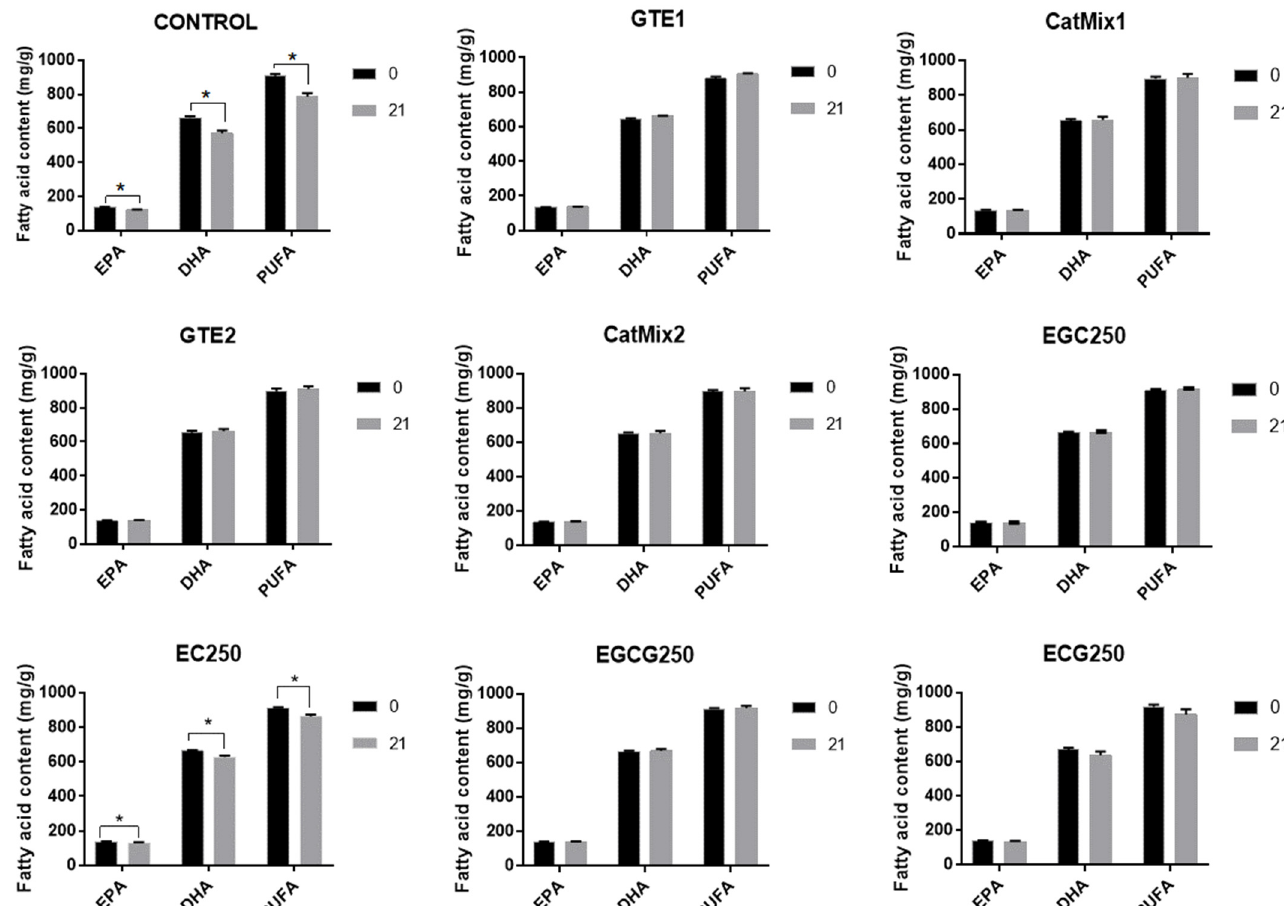
Figure 4. Effect of green tea extracts (GTE) and catechins on the eicosapentaenoic acid (EPA), docosahexaenoic acid (DHA) and total polyunsaturated fatty acid (PUFA) content of a DHA-rich oil after 21 days of storage at 30 °C. Results are expressed as mean ± standard deviation, n = 3. A significant difference between pairs is indicated by a *. Control = DHA-rich oil, GTE1 = DHA-rich oil + 1000 ppm GTE1, GTE2 = DHA-rich oil + 450 ppm GTE2, CatMix1 = DHA-rich oil + reconstituted catechins mixture of GTE1, CatMix2 = DHA-rich oil + reconstituted catechins mixture of GTE2, EGC250 = DHA-rich oil + 250 ppm EGC, EC250 = DHA-rich oil + 250 ppm EC, EGCG250 = DHA-rich oil + 250 ppm EGCG, ECG250 = DHA-rich oil + 250 ppm ECG.